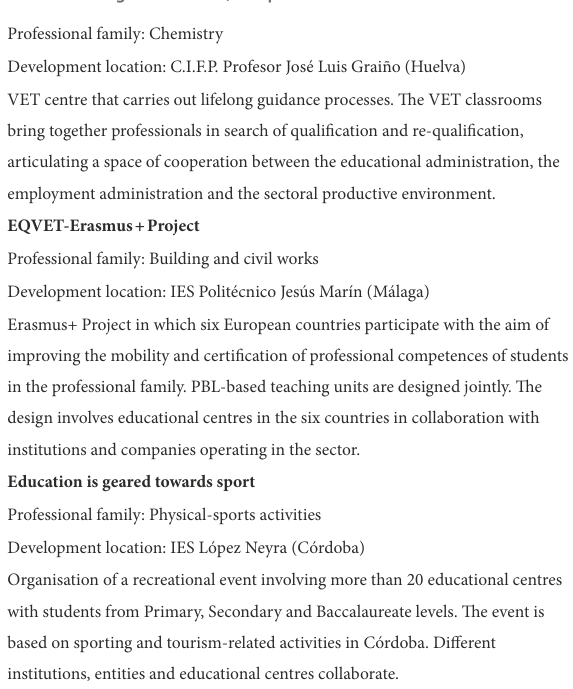
TABLE 4 Integrated centre, unique